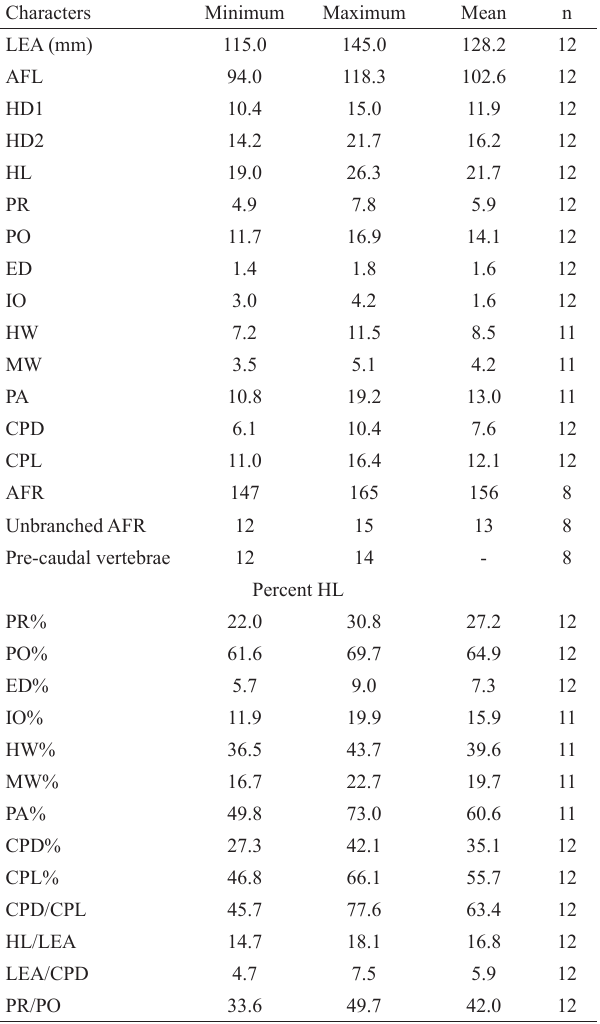
Fig. 15. Sternarchella calhamazon (USNM 373113). a. Lateral view of the body, b. Lateral view of the head, c. Lateral view of the caudal region showing two rows of intermuscular bones in the caudal peduncle and the continuous caudal peduncle membrane. Scale bars = 1 cm. Tab. 4. Morphometrics and meristic measurements for Sternarchella calhamazon